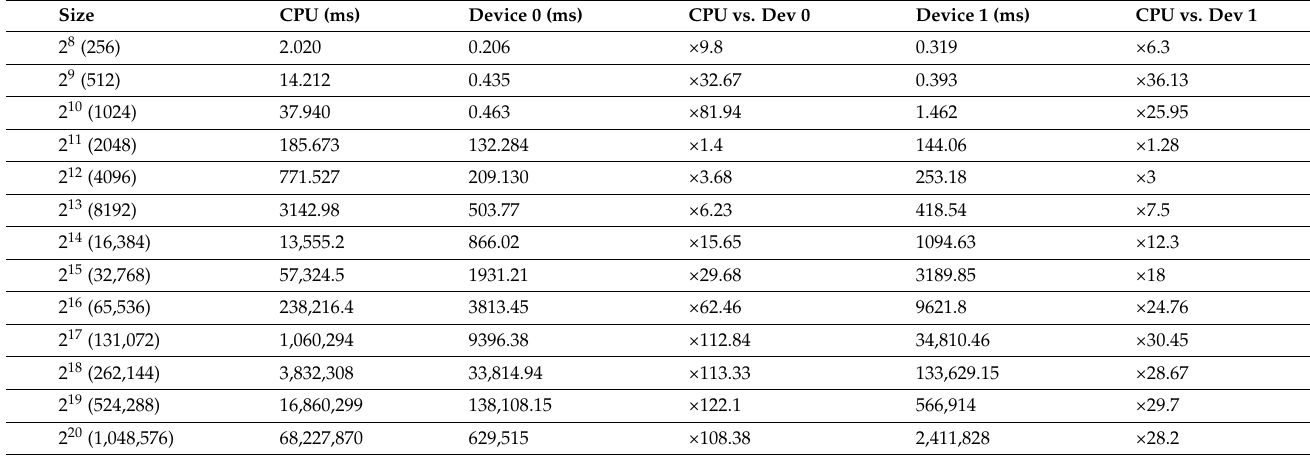
Table 3. Computing autocorrelation